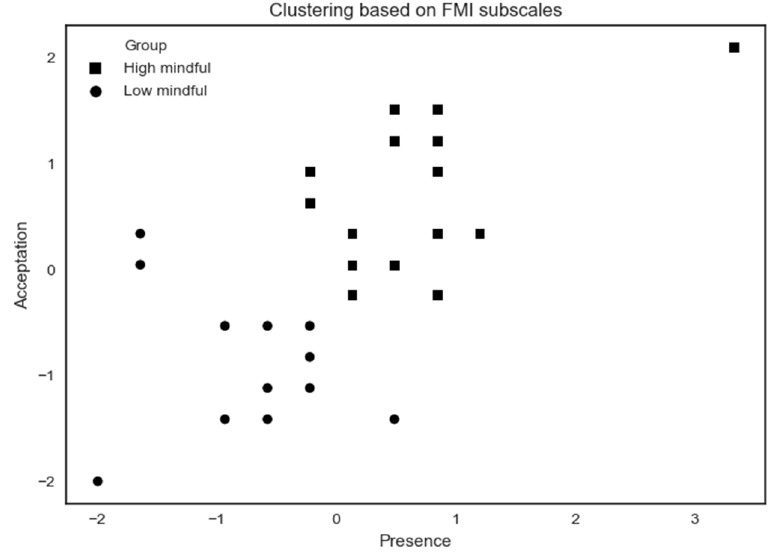
Figure 6. K-means clustering analysis applied to ETOC performance subjects based on FMI subscales. Some participants share the same x- and y-coordinates, causing them to merge at the same point.